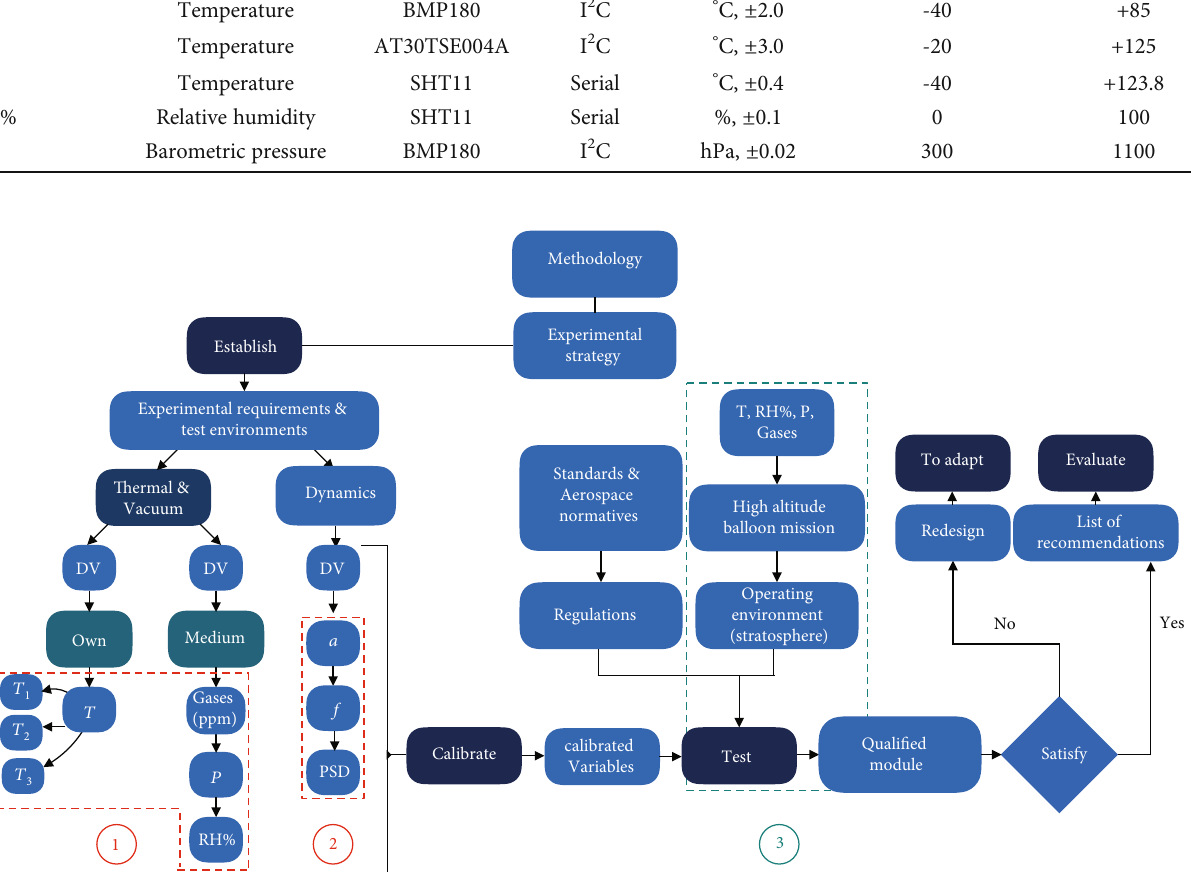
Figure 6: Methodology of blocks and experimental strategies. Dark blue boxes correspond to the goals to meet with the methodology. Blue boxes correspond to the di ff erent steps to meet the goals, and dashed line boxes frame the three test